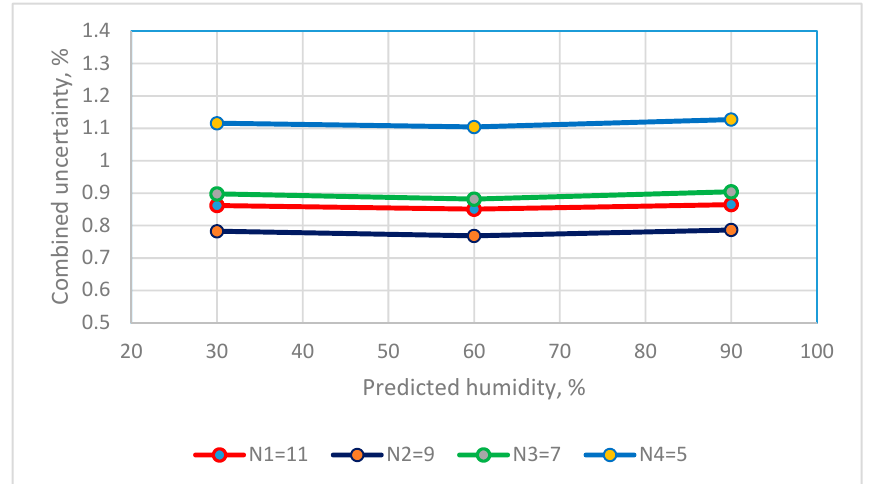
Figure 7. The distribution between numbers of saturated salt solutions and combined uncertainty of resistance RH sensors.